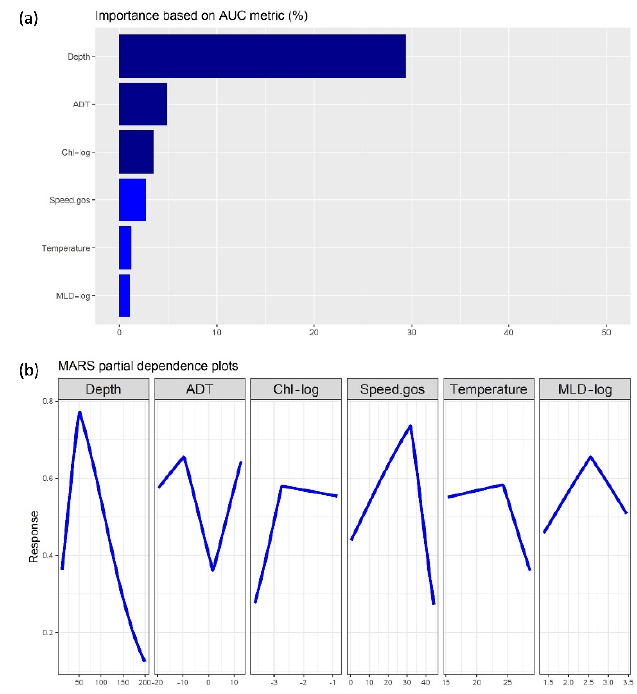
Figure 3. MARS results: ( a ), barplots of variable importance scores based on AUC-metric. The dark blue, blue and light blue colored bars indicate variables with high significance ( p -value < 0.01), moderate significance (0.01 ≤ p -value < 0.05) and no significance ( p -value ≥ 0.05), respectively. ( b ), partial plots of significant ( p < 0.05) parameters are shown.